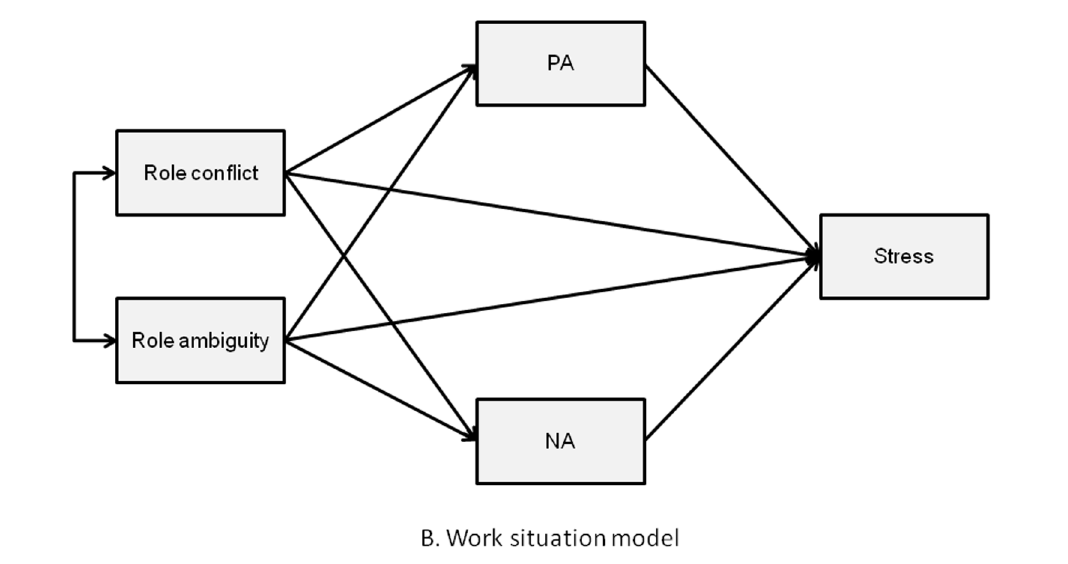
Figure 1.B. Work situational model: The impact of role stress in part mediated by PA/NA to perceived strain.